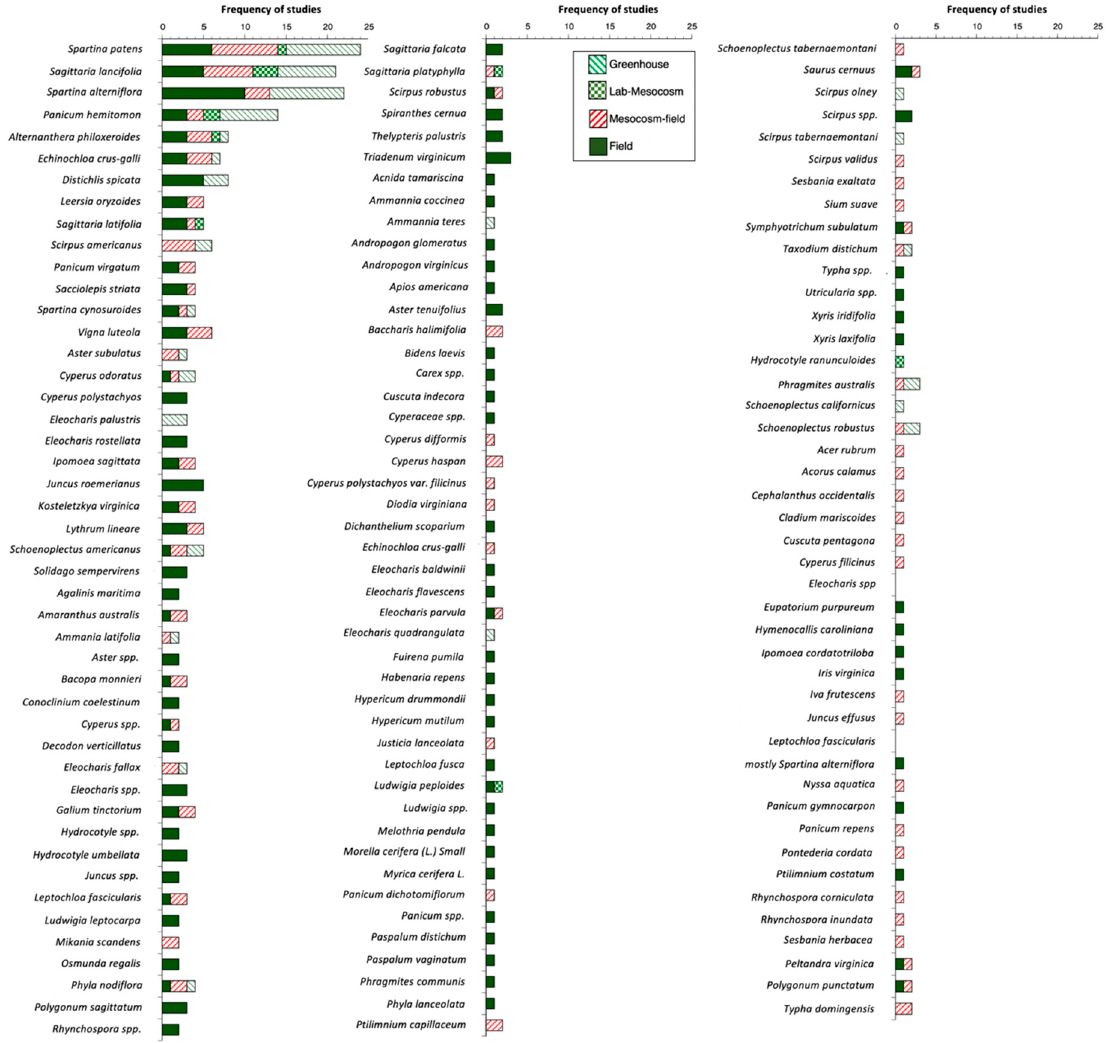
Figure 4. Frequency distribution of ecological studies assessing aboveground vegetation biomass under differential experimental conditions (greenhouse, laboratory-mesocosm, mesocosm-field, and field settings).